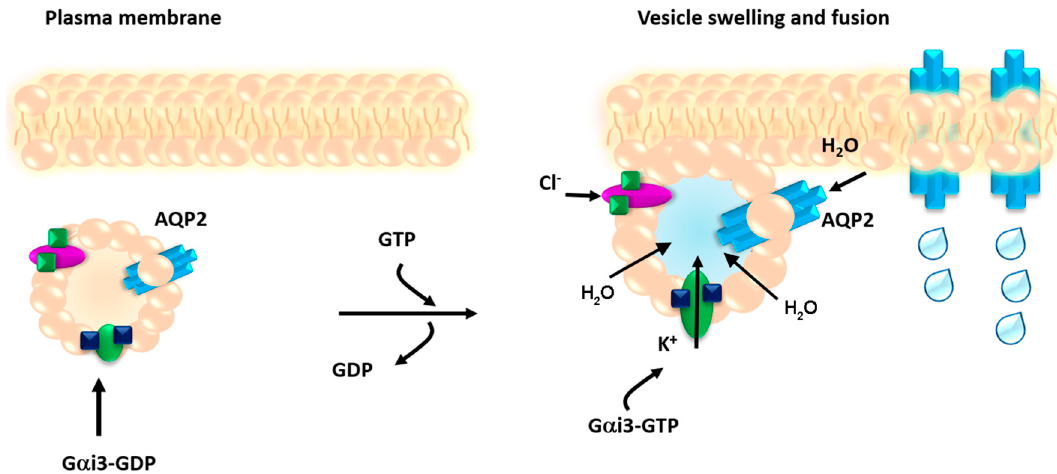
Figure 9. Schematic hypothetical model of AQP2 vesicle swelling. Activation of G α i3 protein results in the opening of K + channels (TASK-2), causing K + entry into the vesicle due to a positive inward chemical gradient. The positive charge of K + is balanced by Cl − entry through ClC-K channels also identified in isolated AQP2 vesicles. This initially created osmotic gradient draws water into the vesicles resulting in vesicles